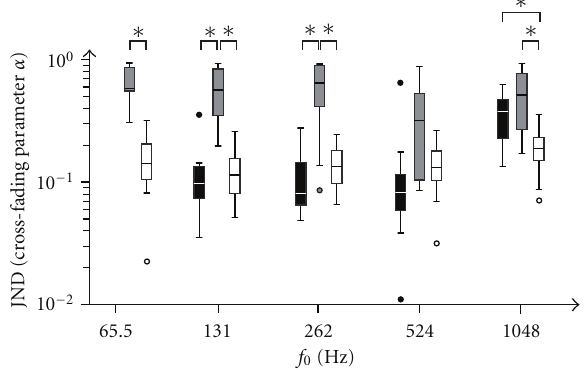
Figure 4: Distribution of the individual spectral shape JND for the normal hearing participants using a Baha (black) or not (white) as well as the CI users (grey) as boxplots for the stimulus conditions of f 0 = 65 . 6Hz, 131Hz, 262Hz, 524Hz, and 1048Hz. Significant di ff erences are marked ( ∗ P < 0 . 05). The globally poorer JND in the CI users and the poorer JND in the Baha users compared to the normal hearing individuals in the f 0 = 1048Hz condition is